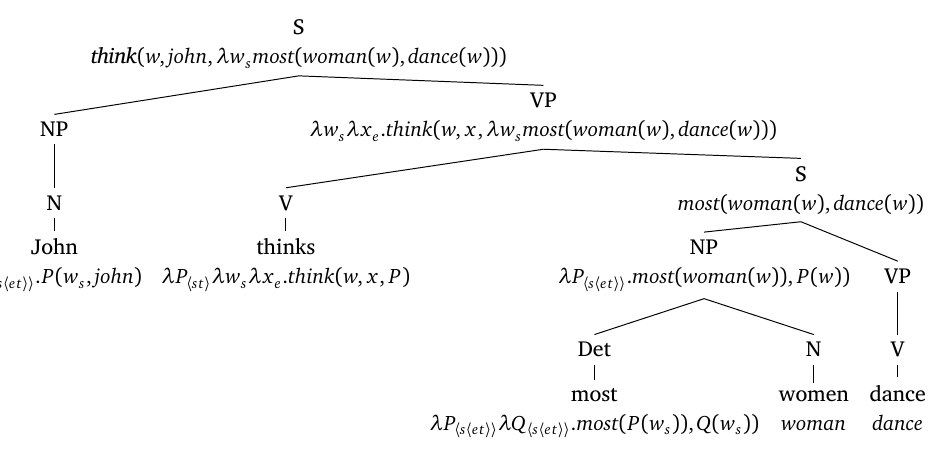
Figure 3: An analysis in our